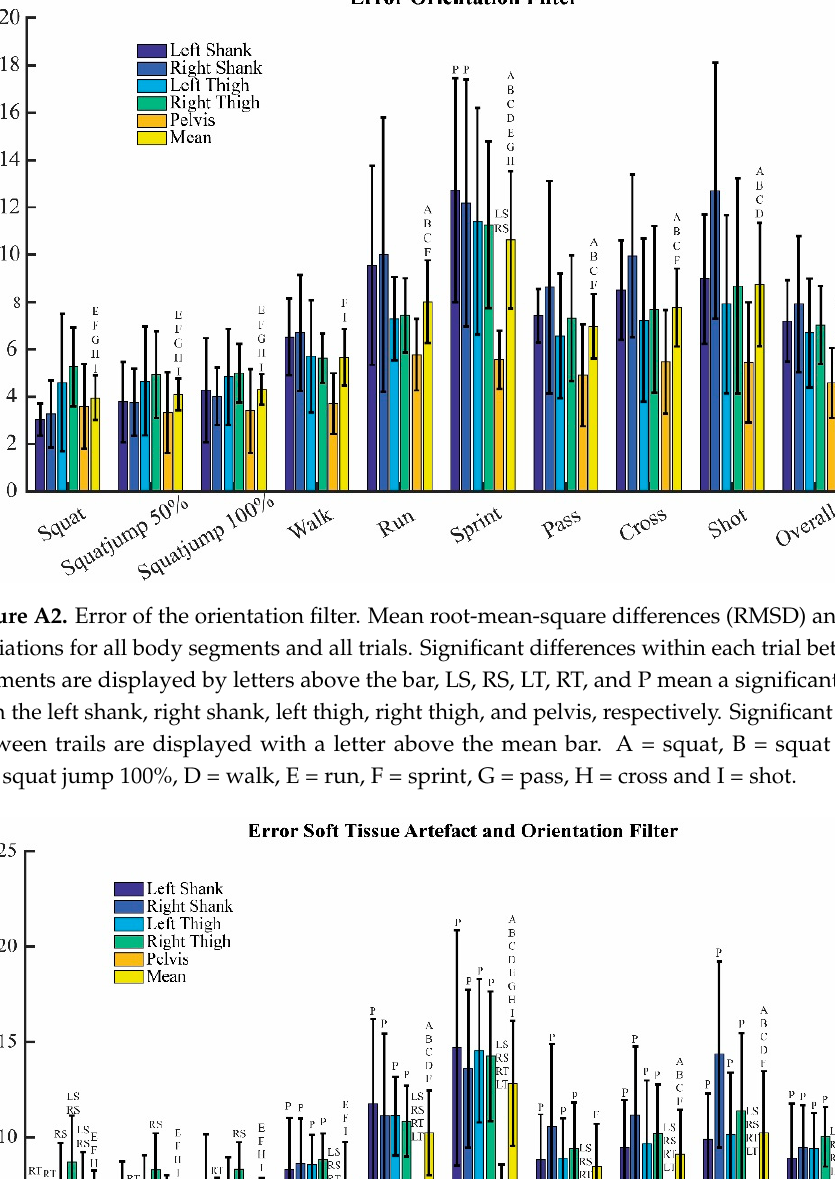
16 of 19 Figure A1. Error caused by the soft tissue artefact. Mean root-mean-square differences (RMSD) and